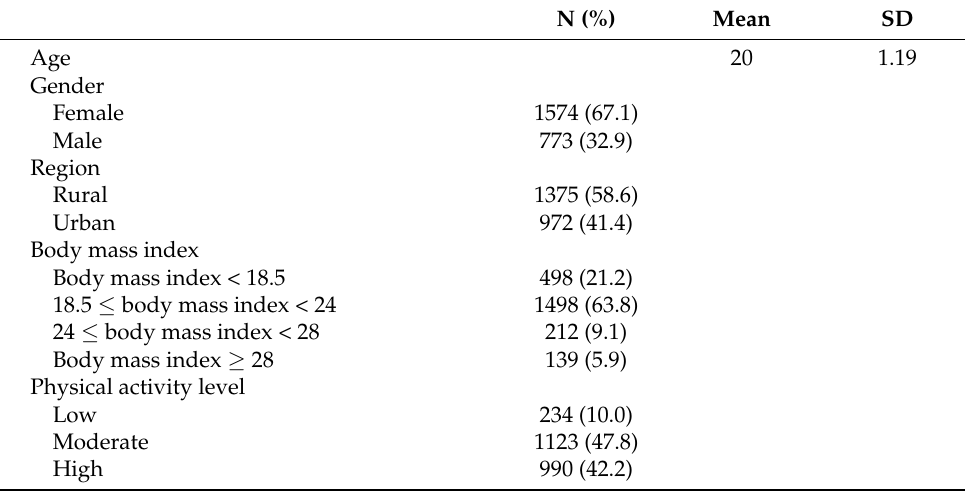
Table 1. Characteristics of Chinese college students (n =